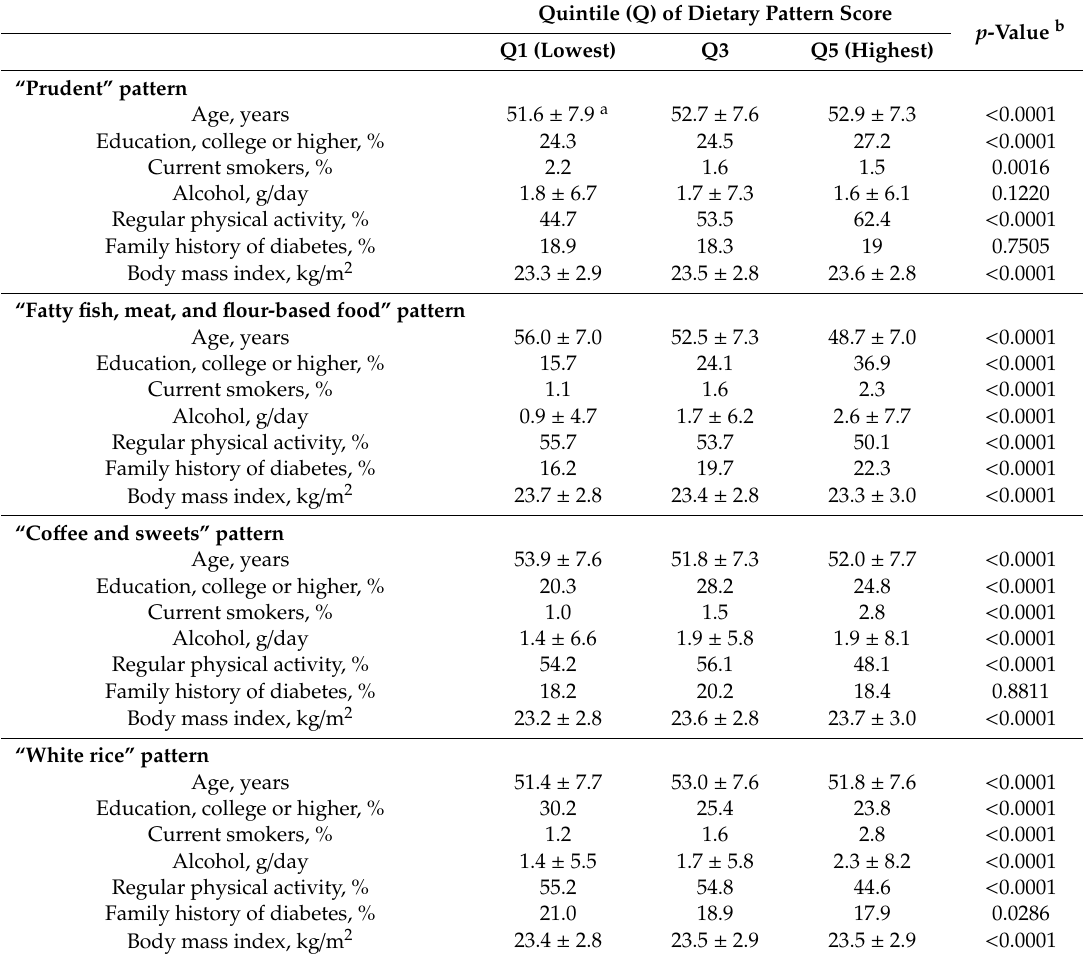
Table 3. General characteristics at baseline across quintiles of each dietary pattern score in the middle-aged Korean women, the KoGES-HEXA study.